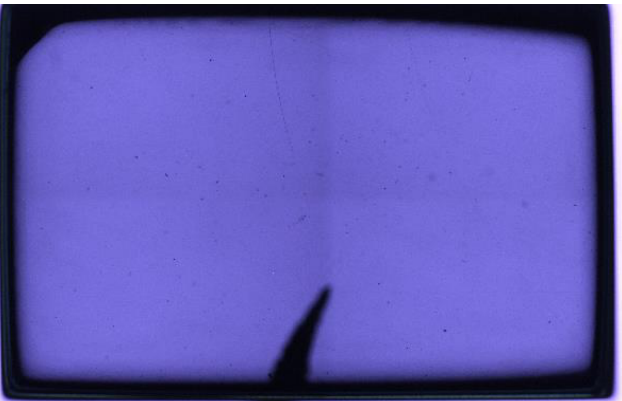
Figure 1. Infrared transmission image (7.00 mm × 4.65 mm) of the cadmium zinc telluride selenide (CZTS) sample, after polishing the surfaces to a mirror-shine finish. The image (composed from four images) was obtained with a Nikon Eclipse LV100 microscope fitted with an infrared light source and camera, a motorized stage with xyz-translation capability, and a software for capturing and analyzing images. The object protruding from the lower side is used to mark and track the wafer placement orientation.